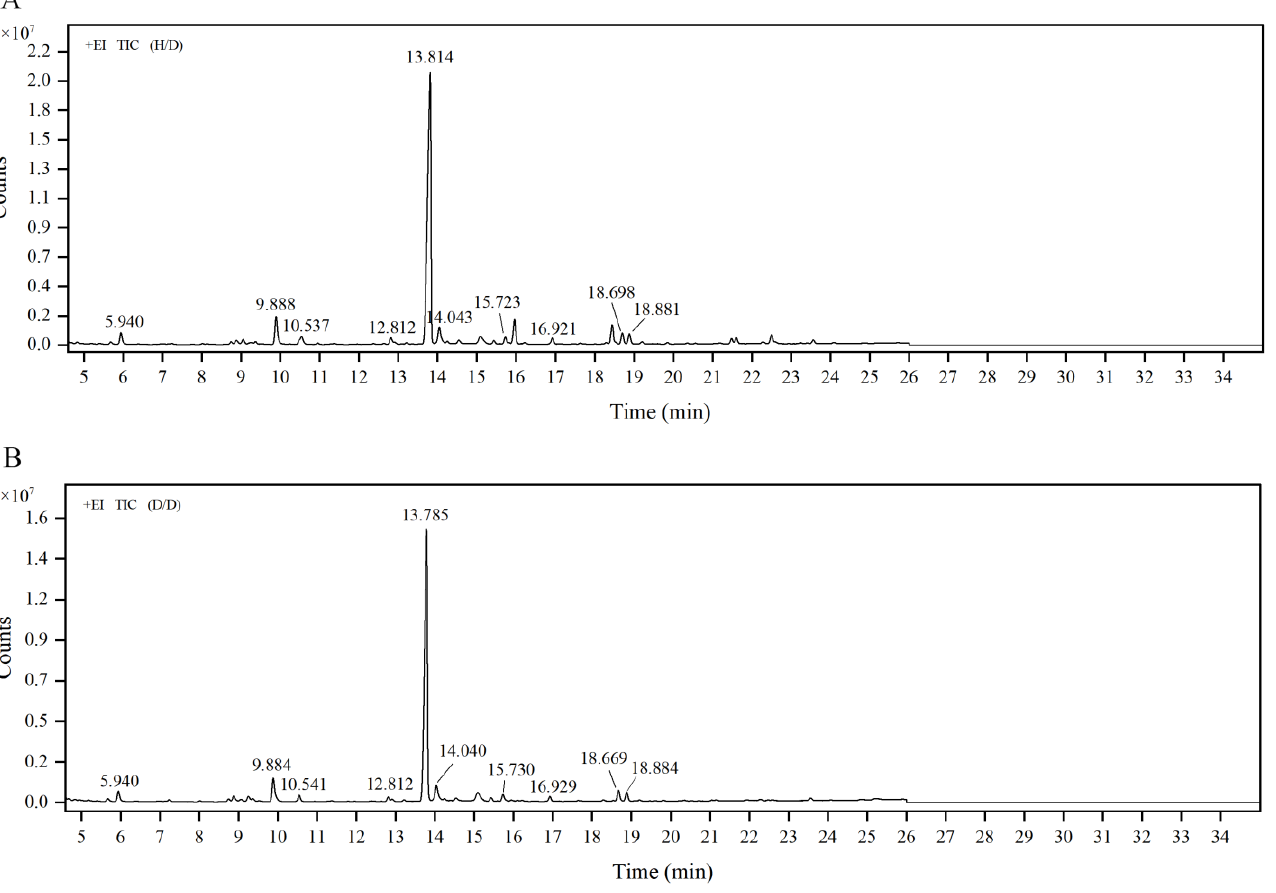
Figure 5. Total ion chromatograms (TIC) of GP2a derivatives. ( A ) H/D, singly deuterated sample, referring to the carboxyl groups prereduced using sodium borohydride (NaBH 4 ) and secondary reduced using sodium borodeuteride (NaBD 4 ) after methylation. ( B ) D/D, doubly deuterated sample, referring to the carboxyl groups reduced using NaBD 4 before and after methylation. +EI: electron bombardment ion source. Table 2. Methylation analysis result of